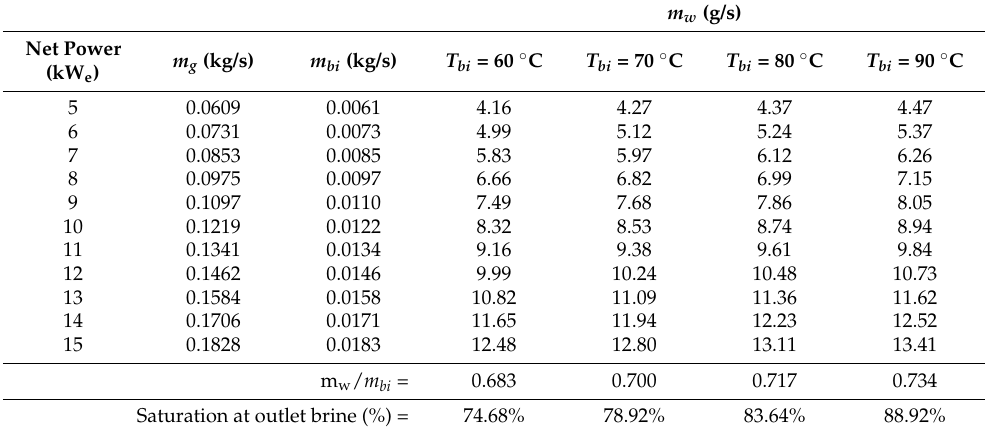
Table 8. Water evaporated for SMGT; Pressure Ratio = 4.5, T gi = 285.09 ◦ C, S bi = 0.07 kg/kg, S sat = 0.296 kg/kg, m g / m bi =